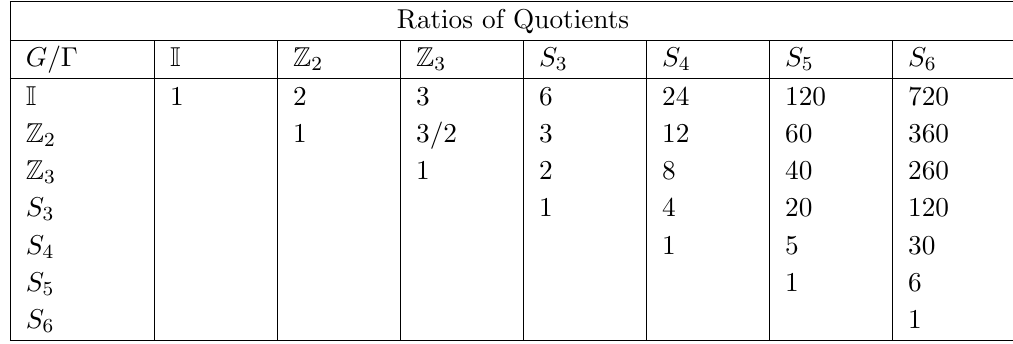
Table 4 . Ratios of t = 1 Hilbert Series poles for k = 3, n = 3